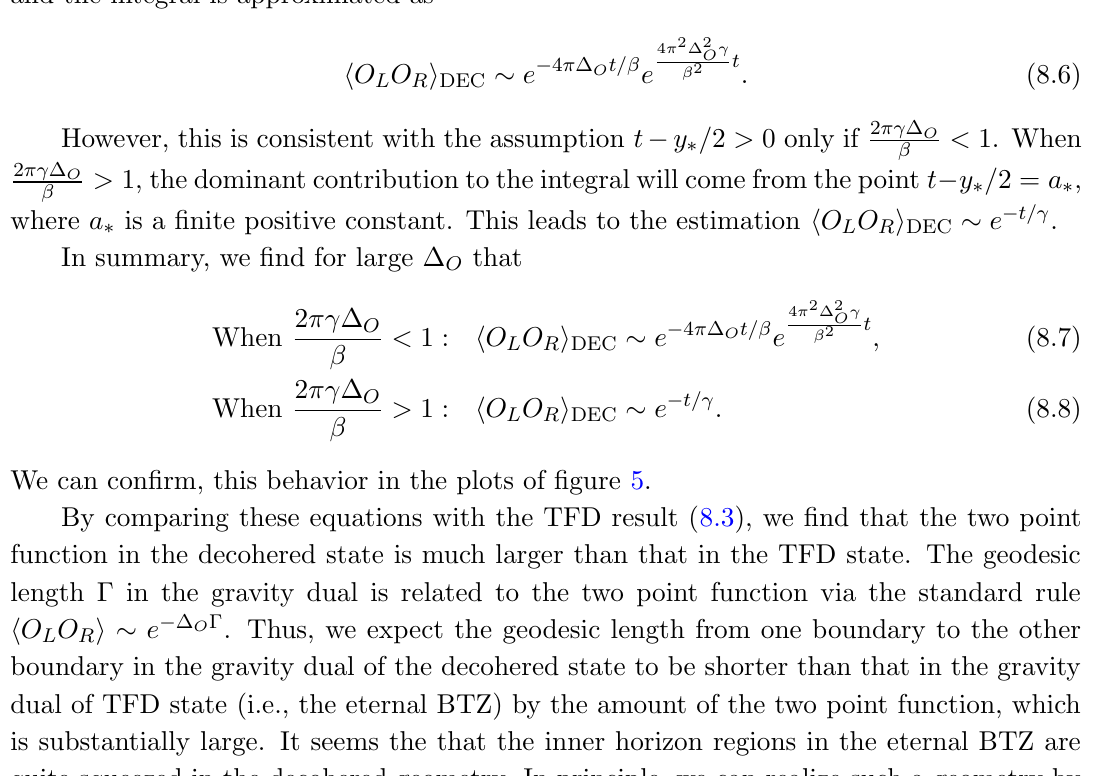
(cid:13)=(cid:12) . The O